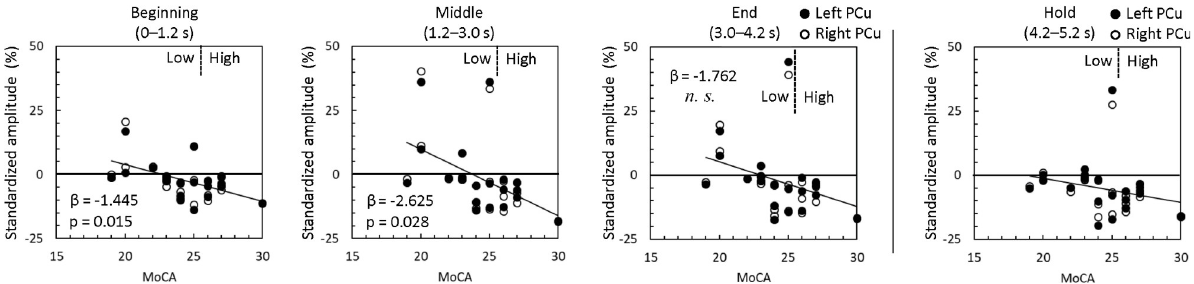
Fig 6. Correlations between MoCA score and standardized PCu alpha-rhythm amplitude. Repeated measures linear regression analysis demonstrated that MoCA score significantly correlated alpha-rhythm amplitude in the beginning and middle sub-periods. Note that the analysis only considered bilaterally averaged PCu values for the MIP sub-periods (n = 20; some data points are overlapped). Left and right PCu, and holding values are shown for display purposes.